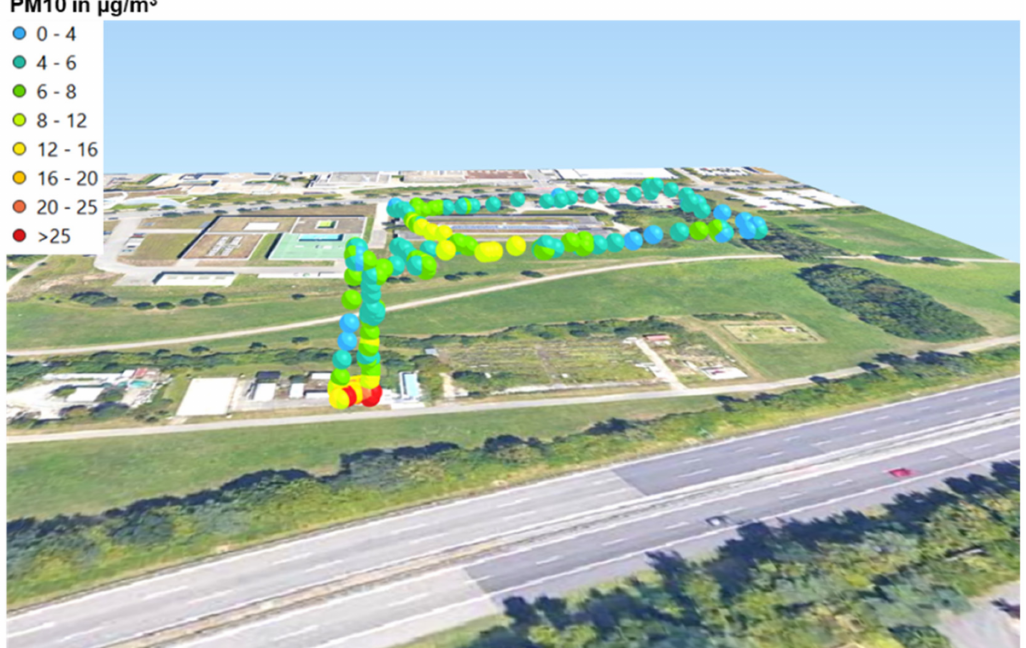
Figure 15. Three-dimensional visualization of the PM10 concentrations measured with the OPC-N3 during the horizontal flight at 30 m AGL performed at 13:41 on 23 January